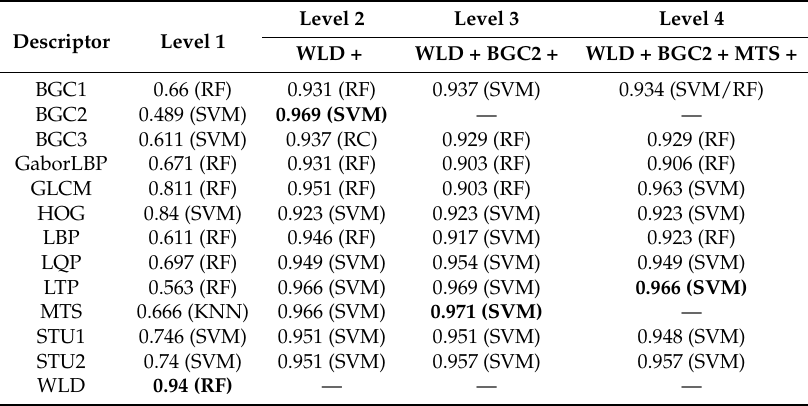
Table 1. Forward Subset Selection of descriptors applied to the whole image (also known as FSS 4 × 4). Level 1 uses only one descriptor. The following levels concatenate the best descriptor from the previous level to the rest of the descriptors. The algorithm stops on level 4 because the evaluation measure is not improved from level 3 to 4.